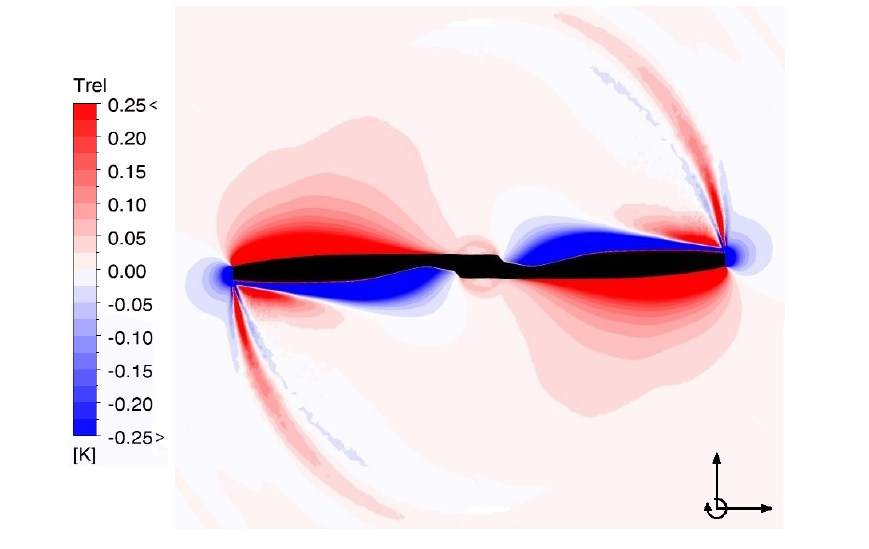
Figure 8. Top view showing the contours of relative temperature during climb flight at 6.5ms − 1 . The relative temperature varies between − 0.25 and 0.25 K, although lower or higher values can be reached near the surface of the